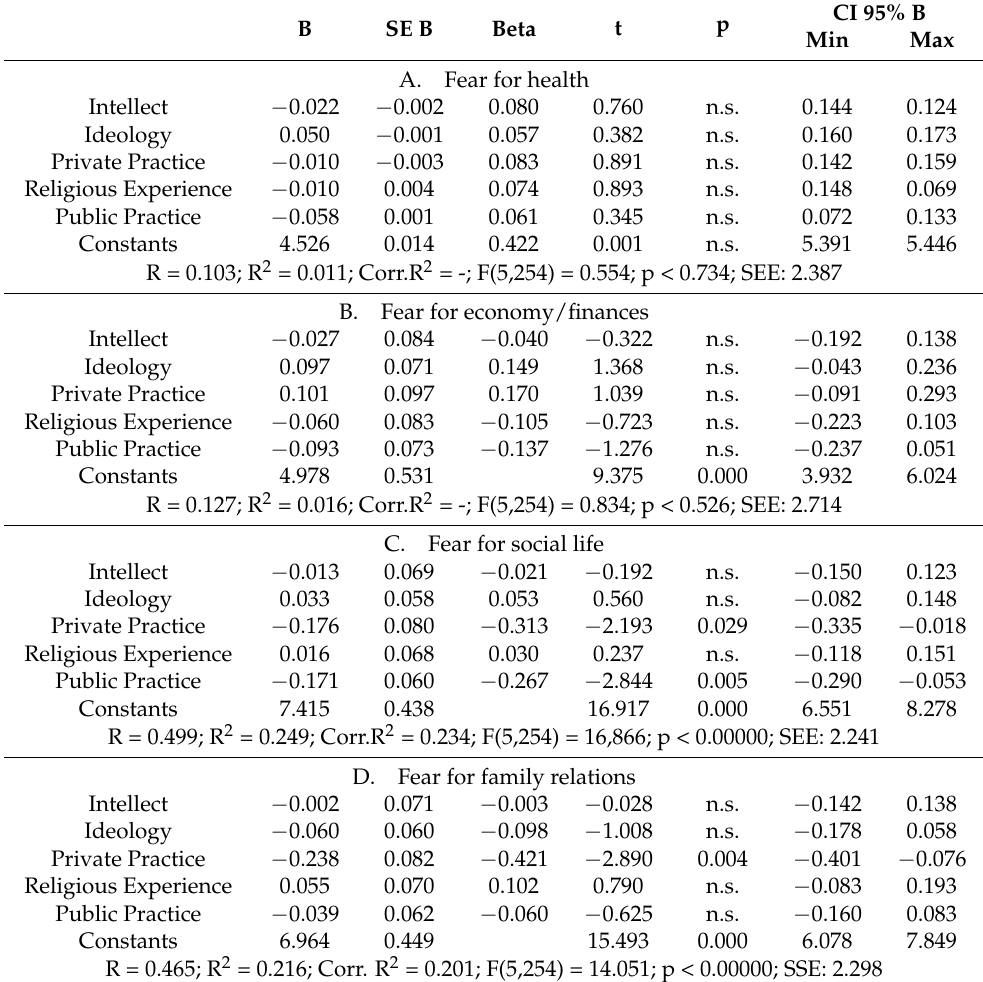
Table 5. Summary of a multiple regression analysis predicting level of types of COVID-19